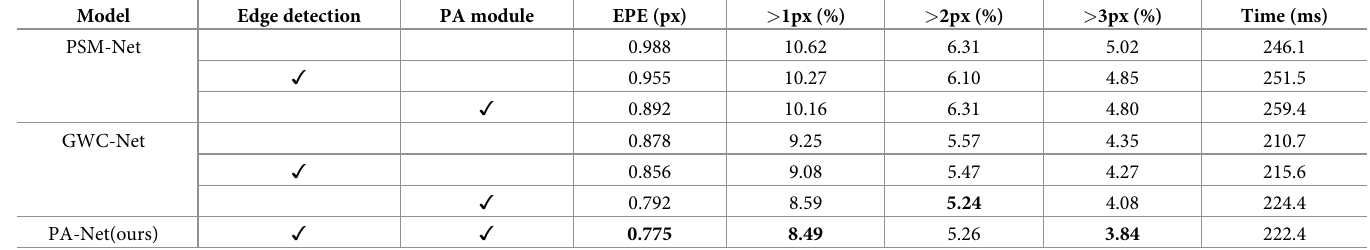
Table 1. Ablation study results of PSM-Net, GWC-Net and PA-Net on the datasets of Scene flow [8]. The results of PSM-Net [21] and GWC-Net [13] are trained with published code with our batch size, evaluation settings for fair comparison. Model